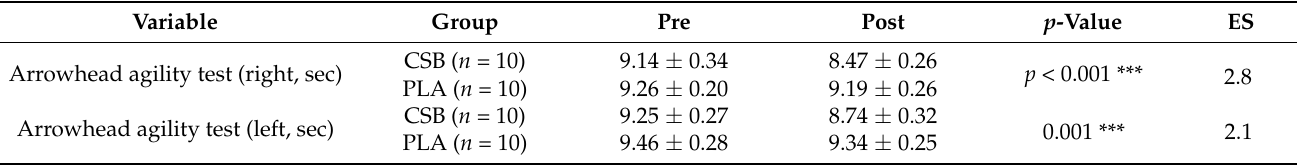
Table 4. Change of arrowhead agility test following combined creatine and sodium bicarbonate supplementation. Variable Group Arrowhead agility test (right, sec)